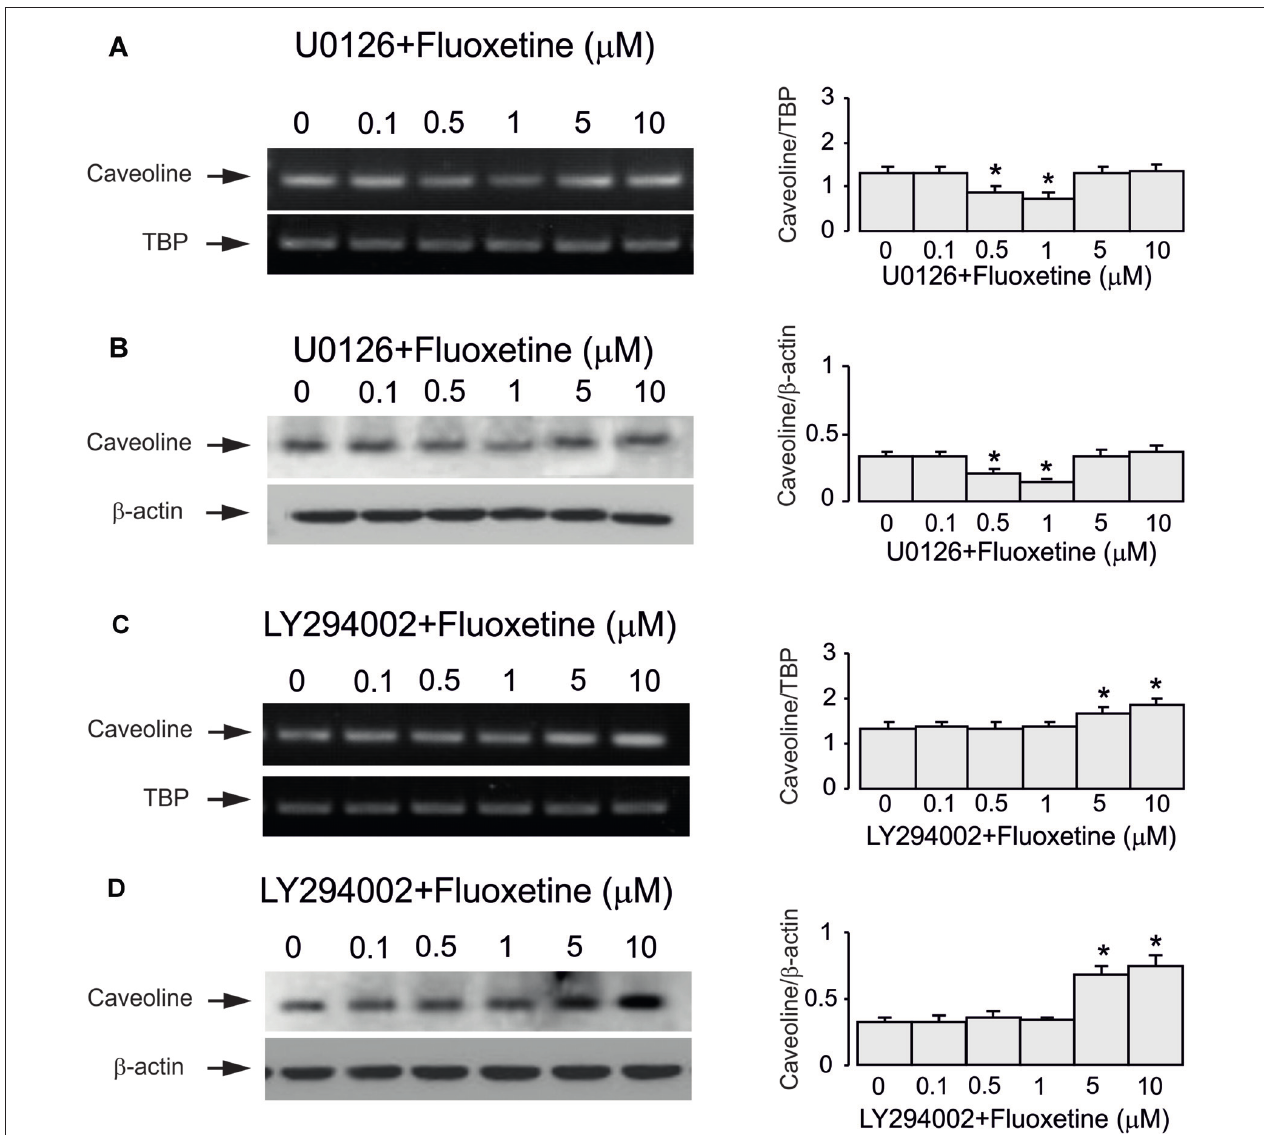
FIGURE 5 | Regulation of mRNA and protein expression of Cav-1 by chronic treatment with fluoxetine requires ERK or AKT activation in astrocytes. Cells were incubated for 2 weeks without any drug (0 µ M fluoxetine, control) or with 0.1, 0.5, 1, 5, or 10 µ M fluoxetine in the presence of U0126, an inhibitor of MEK or LY294002, an inhibitor of PI3K. (A,C) Southern blots from representative experiments. Similar results were obtained from three independent experiments. Average mRNA expression was quantified as ratio between Cav-1 and TBP, used as a house-keeping gene. (B,D) Immunoblots from a representative experiments. Similar results were obtained from three independent experiments. Average protein expression was quantified as ratio between Cav-1 and β -actin, used as a house-keeping gene. SEM values are indicated by vertical bars. ∗ Indicates statistically significant ( P < 0.05) difference from all other groups but not from each